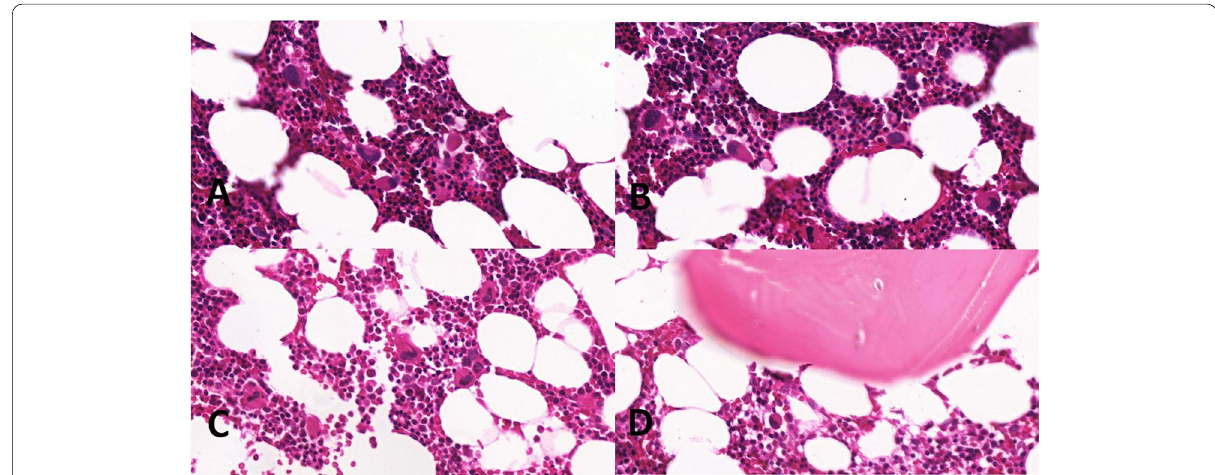
Fig. 1 Bone marrow biopsy from a patient with IPT. A , B and C ‑ Megakaryocyte hyperplasia with dysplasia, D ‑ Ectopic megakaryocytes. (A, B, C, D H&E,